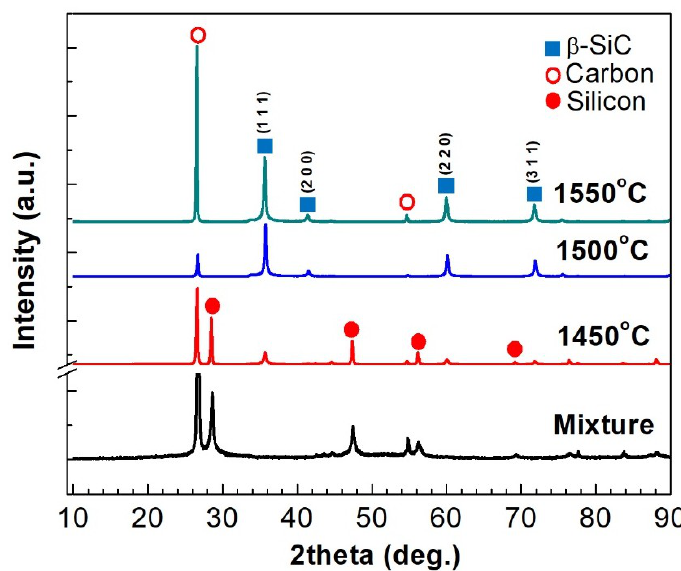
Figure 5. XRD patterns of the products after SiC synthesis treatments.